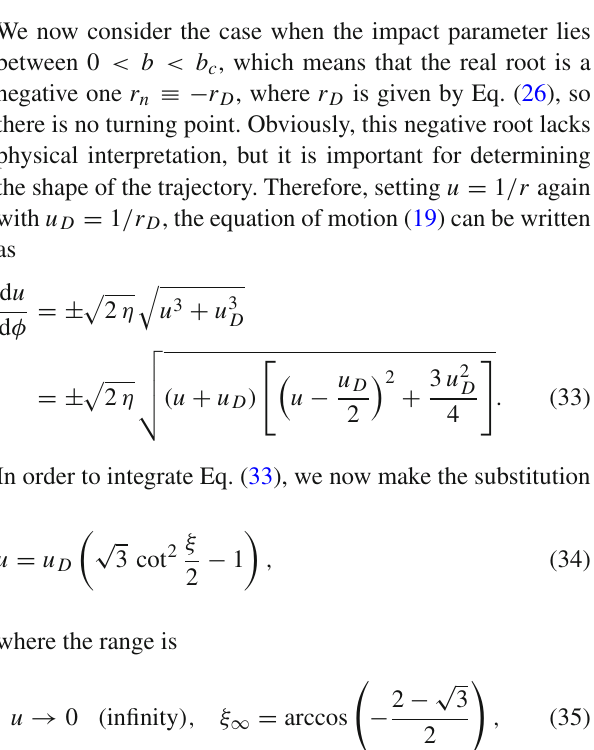
tory depends on the impact parameter and is shown in Fig. 4 for photons falling from r t .